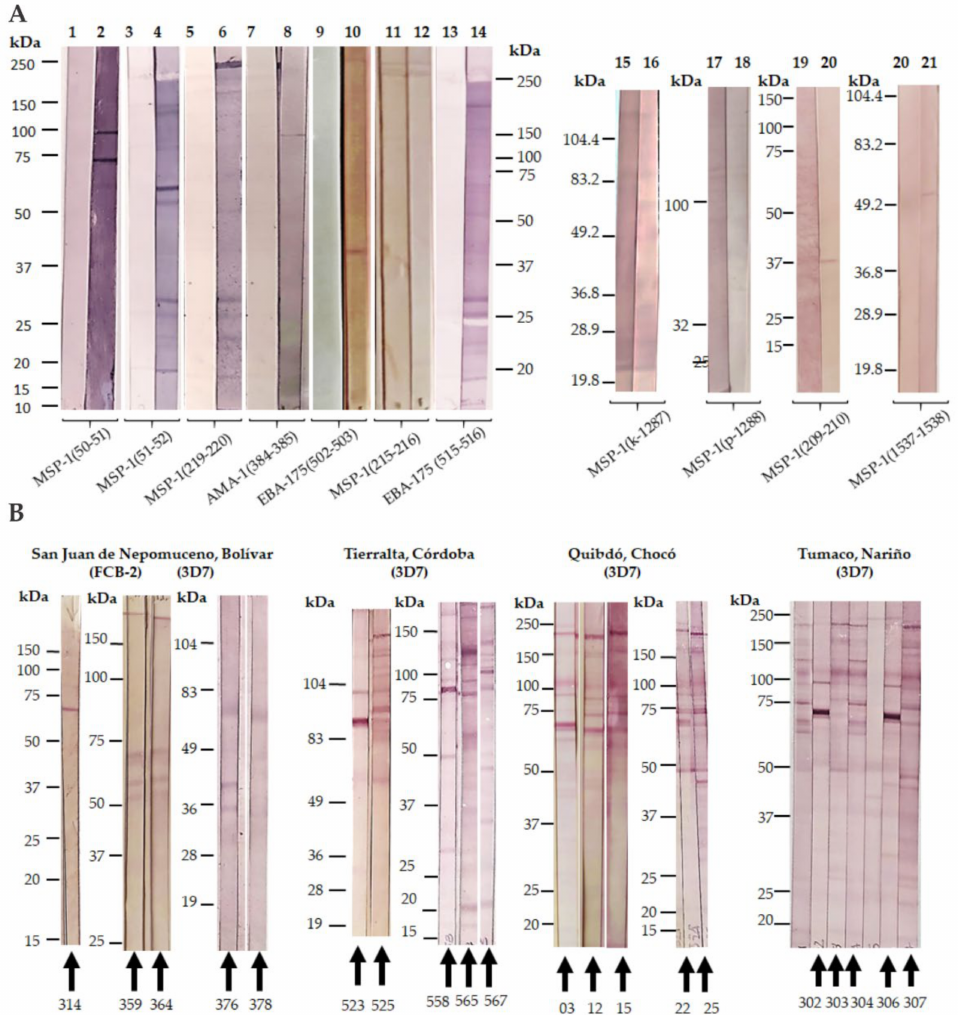
Figure 4. ( A ) Reactivity of serum-antibodies of BALB/c mice immunized with selected blood- stage modified epitopes from P. falciparum , versus the 3D7 strain by Western blot. ( B ) Human sera reactivity of samples collected from Colombian malaria endemic areas versus P. falciparum 3D7 and FCB-2